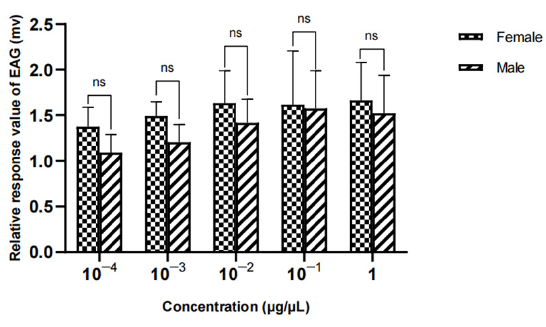
Figure 26. Comparison of EAG responses of W. magnifica to propyl butyrate.